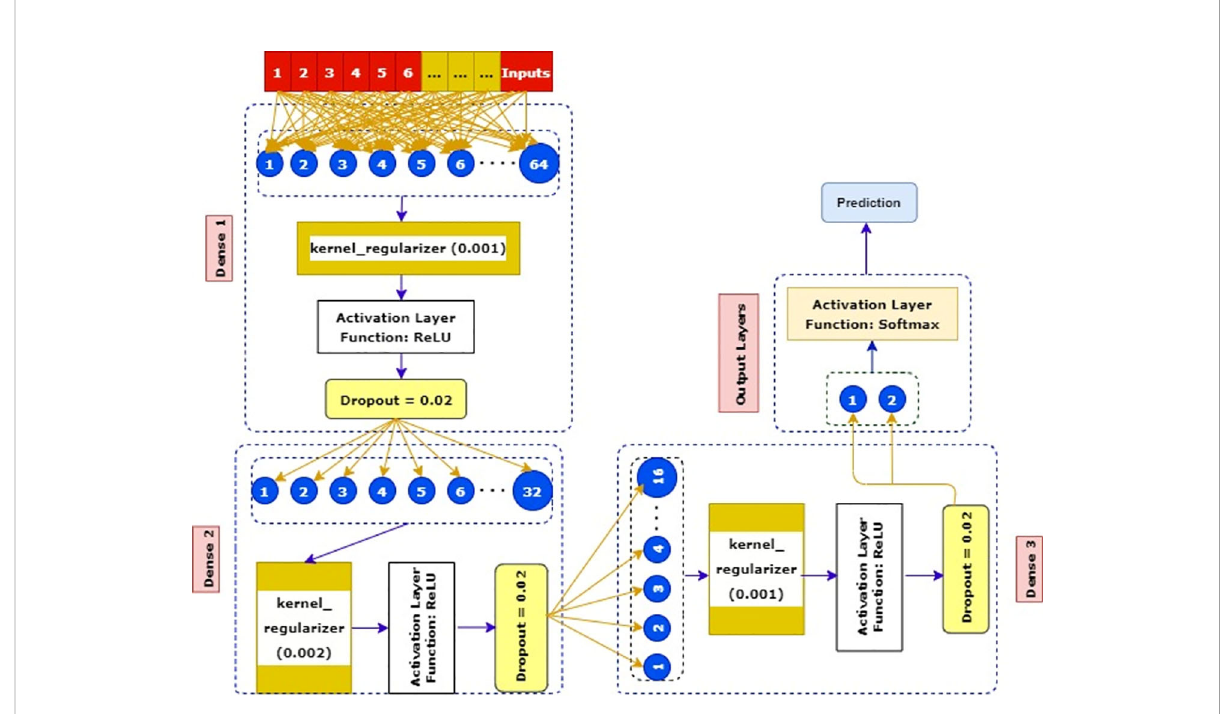
FIGURE 8 A robust architecture of our pruposed SkinNet - 16 neural network.